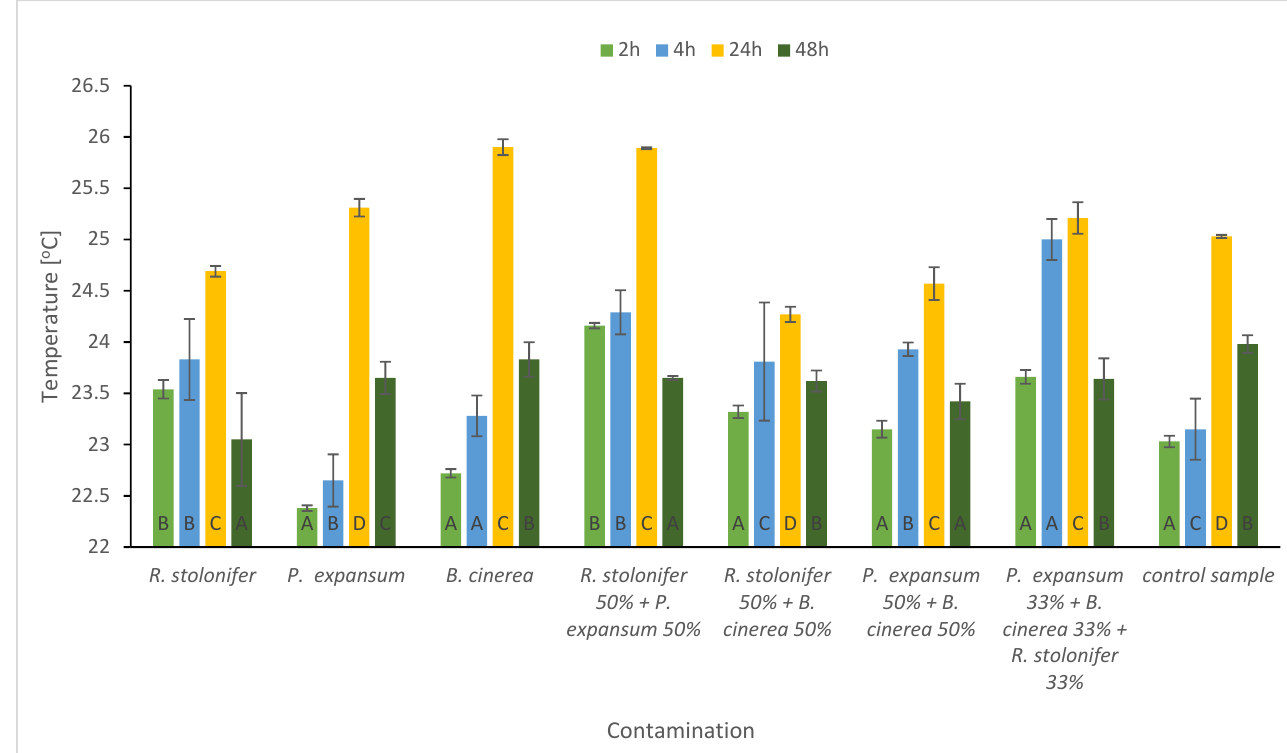
Figure 3. Temperature changes in apples contaminated with molds recorded during 48 h incubation ( A – D ) — homogeneous groups determined for the given contamination variant.